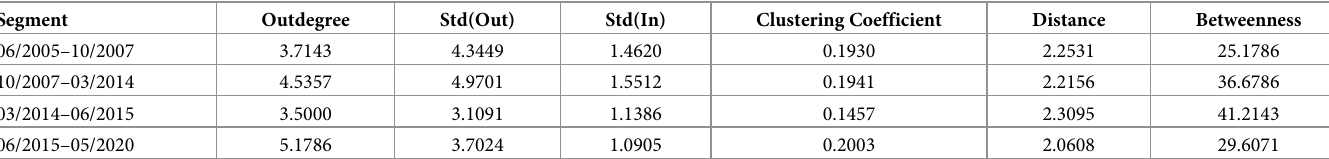
Table 6. Results of industry index over four segments based on